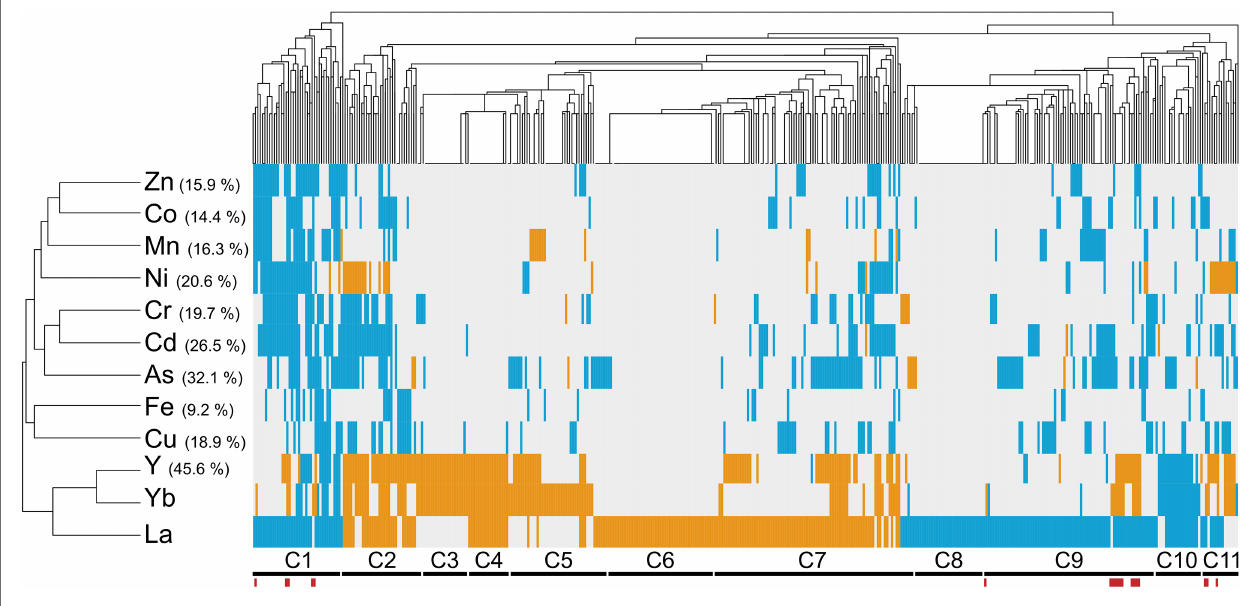
FIGURE 2 | Cross-comparison of mutant phenotypes to lanthanides versus other metallic stressors. Hierarchical clustering of lanthanide sensitivity or resistance- conferring mutations with the mutant response profiles obtained for other metallic stressors. References to these studies are provided in Supplementary Table S4 . The x-axis corresponds to gene-deleted mutants, and the y-axis indicates the different stressors from previously published genomic phenotyping screens conducted on yeast deletion mutant collections. Mutants exhibiting either an enhanced sensitivity or resistance compared to the WT are shown in blue and orange, respectively. Correlation was used as distance measurement to cluster mutants based on metal susceptibility. Clusters of mutants are mentioned below (C1–C11), with mutants displaying an opposite phenotype between La and Yb exposure indicated by red bars. Values in brackets denote the percentage of mutants that were found common between the present screen (La and Yb) and screens with other